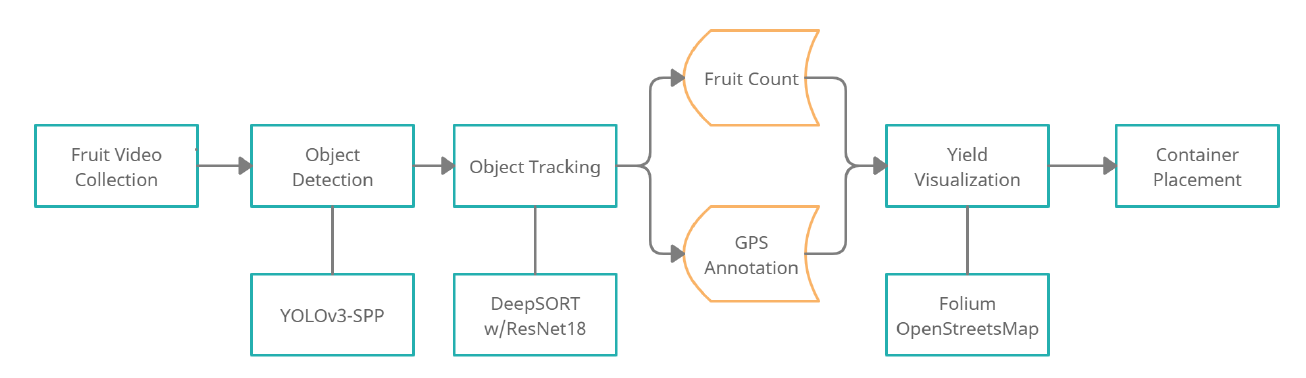
Figure 1. An end-to-end overview of the proposed smart harvesting